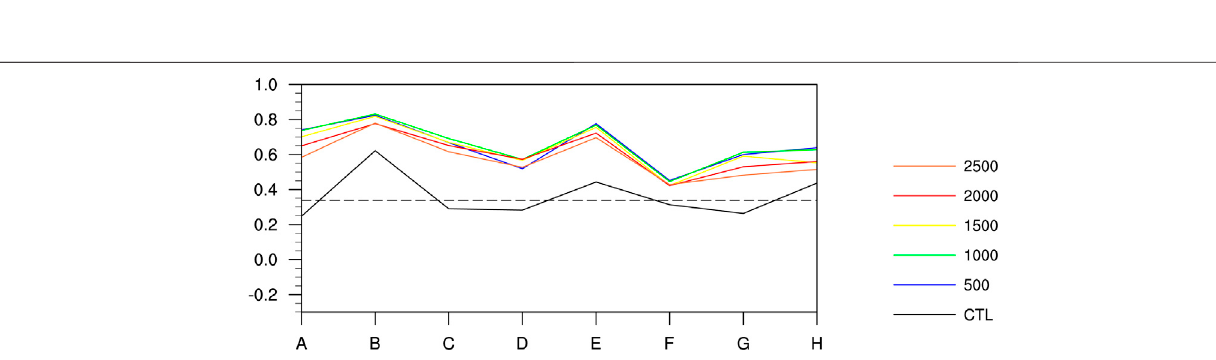
Frontiers in Earth Science |